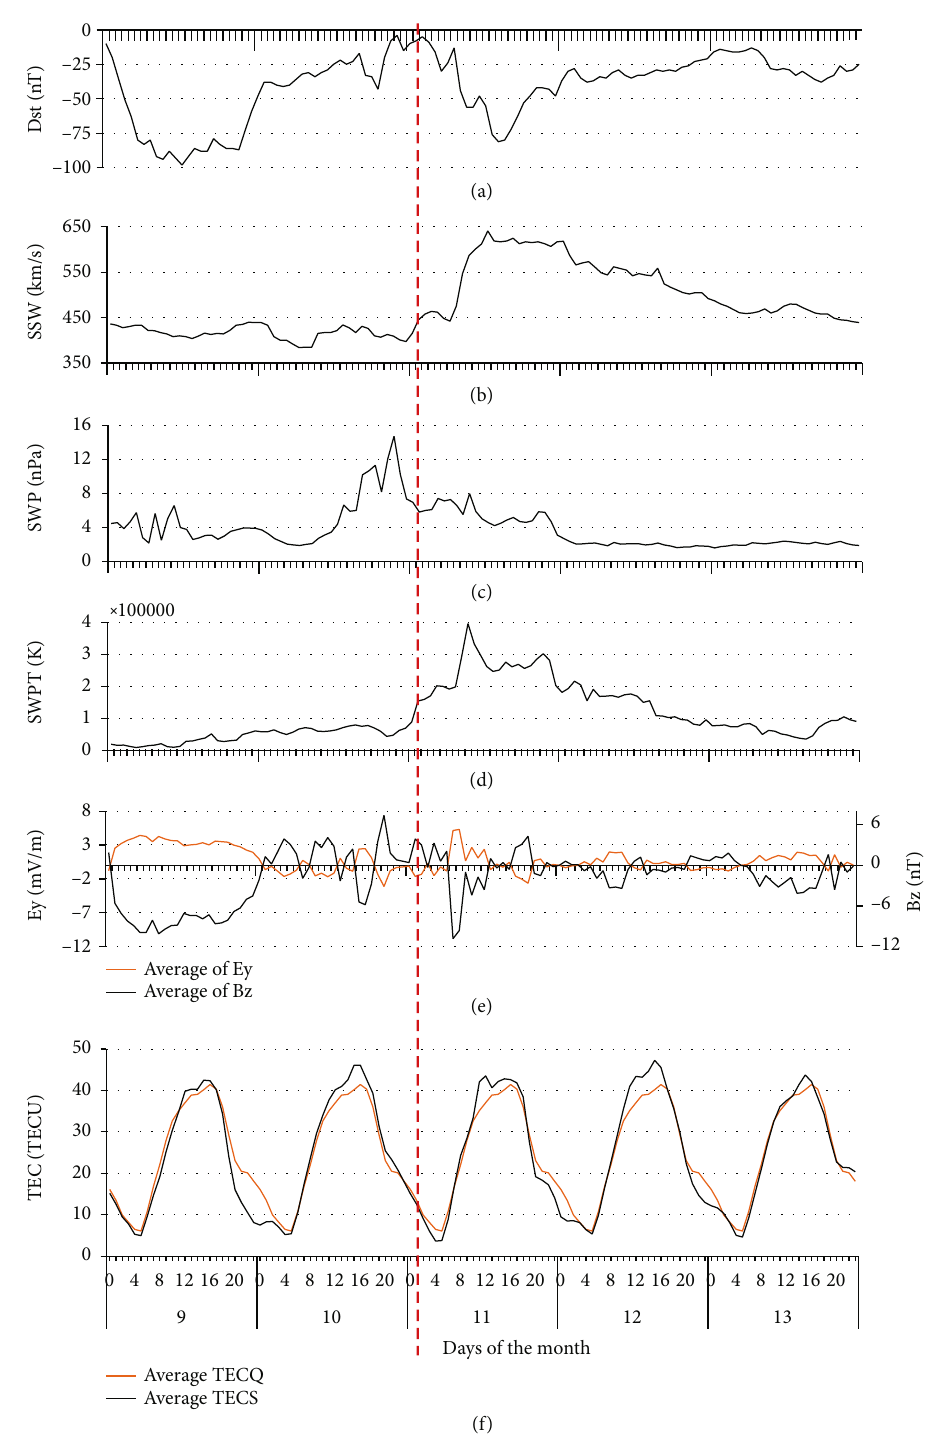
Figure 3: Variation of solar wind parameters and total electron content (TEC) from September 09 to 13, 2015, at the Koudougou GPS